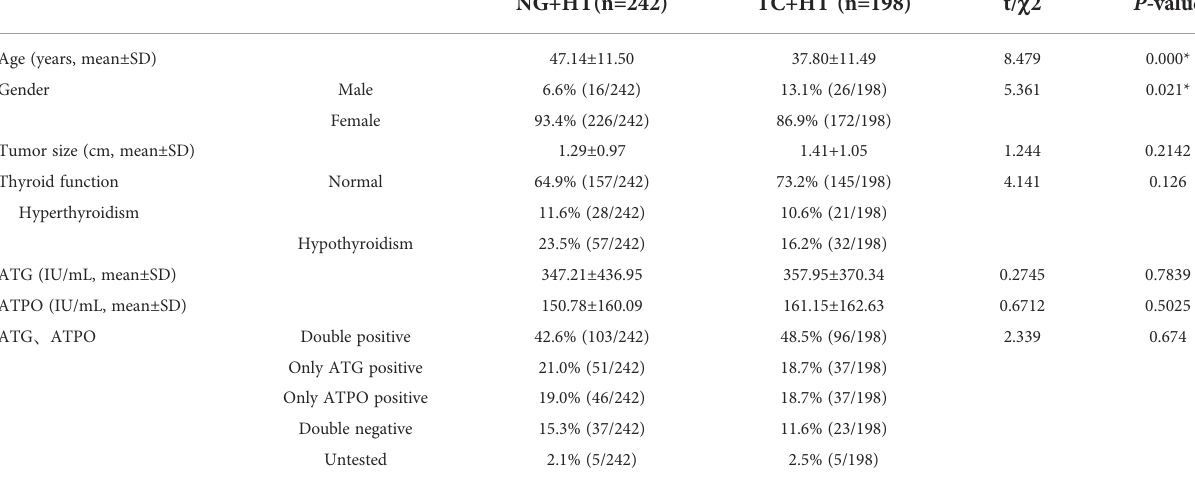
TABLE 1 Patient characteristics of nodular goiter with HT and TC with